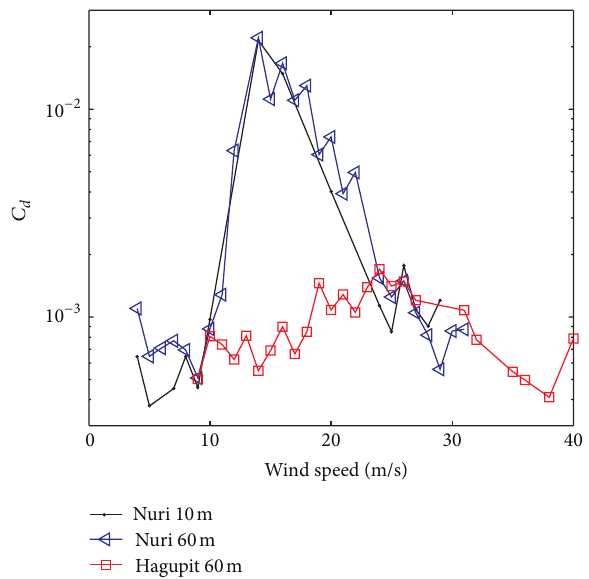
Figure 9: Average drag coefficient of typhoons Hagupit and Nuri in onshore direction, and the wind speed bin is